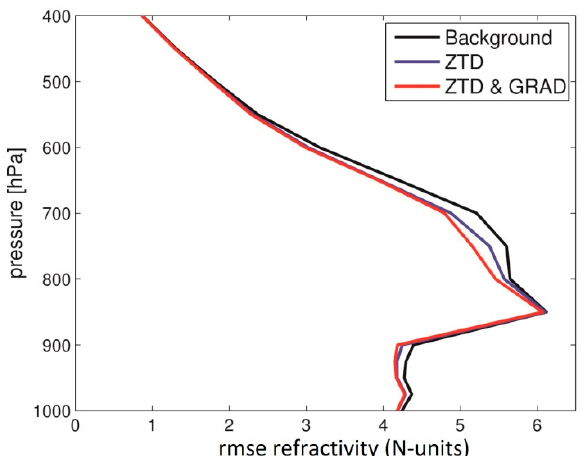
Figure 12. The root mean square error of the refractivity as a function of the pressure for the background (black line), when we assimilate ZTDs only (blue line) and when we assimilate both ZTDs and horizontal delay gradients (red line). GNSS ZTDs and horizontal delay gradients from the G-Nut/Tefnut software for the single station Potsdam are assimilated four times per day (0, 6, 12, 18 UTC) for a period of two months (June and July, 2017). For details refer to the text.